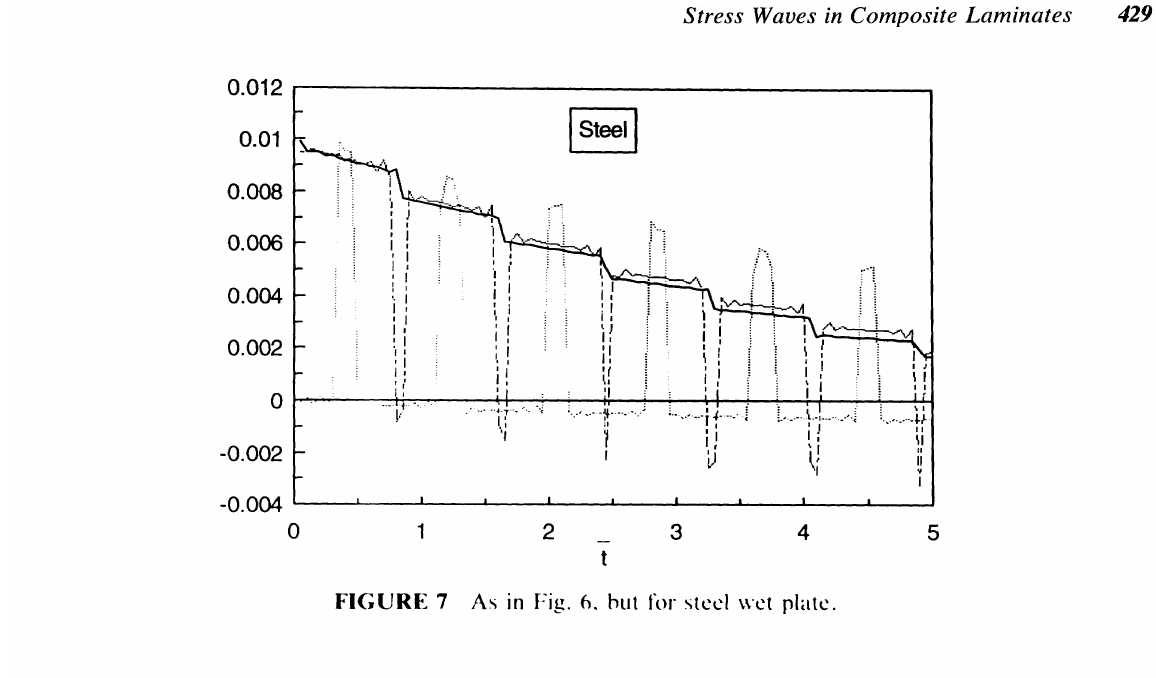
FIGURE 7 As in Fig. n. hut for sted wet plate.